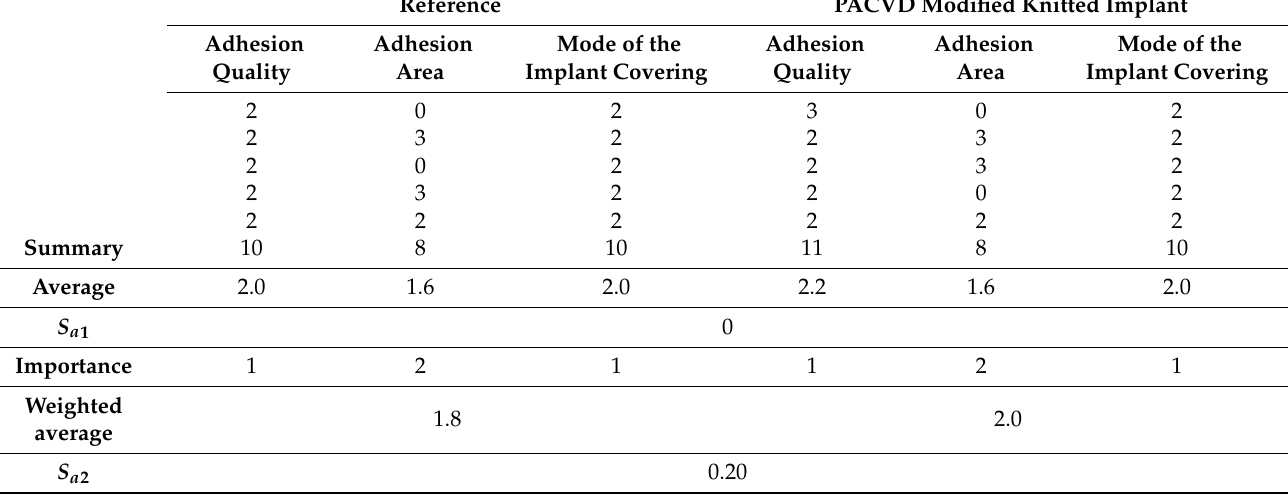
Table 5. Semi-quantitative, macroscopic evaluation of the adhesion susceptibility of the PACVD- modified implants in relation to the reference (unmodified by PACVD) sample after 2 weeks of the intra-abdominal implantation.